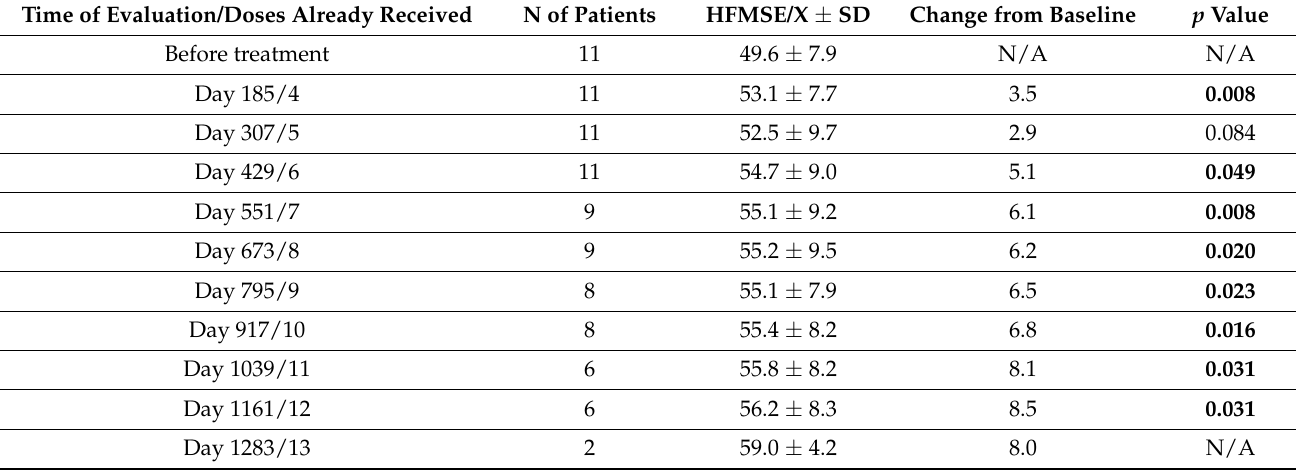
Table 4. The average HFMSE scores by the time points of the nusinersen injections in paediatric SMA type 3 patients.